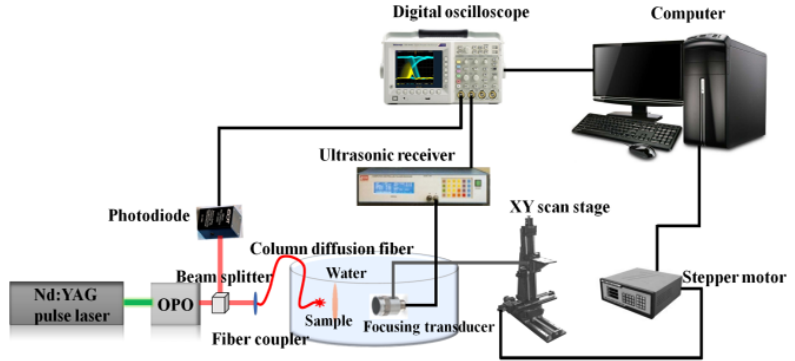
Fig. 2. Experimental setup of photoacoustic scanning imaging